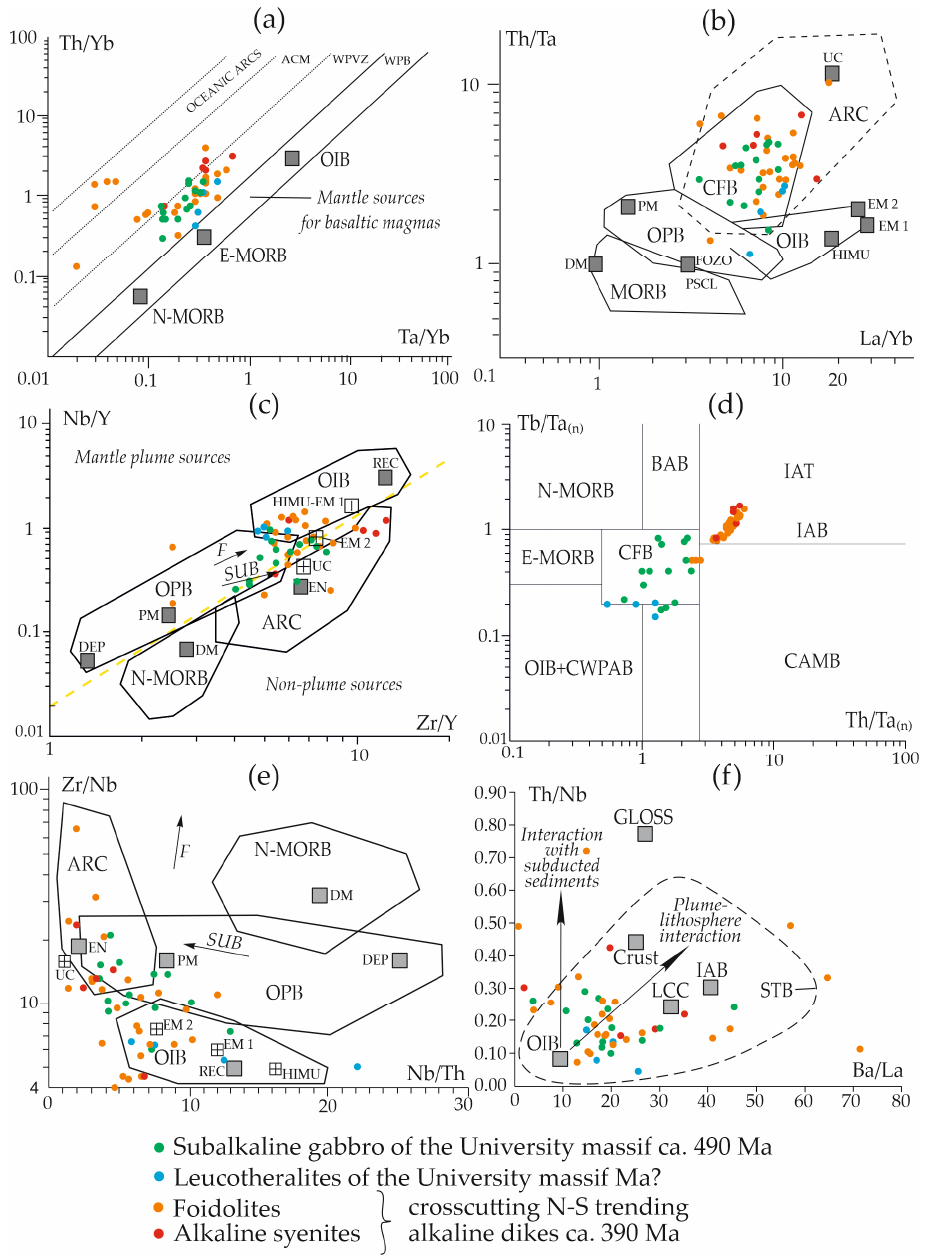
Figure 11. Variation diagrams of HFSE in subalkaline and alkaline rocks of the University pluton. ( a ) Th/Yb–Ta/Yb [80]: Oceanic arcs, ACM = active continental margins, WPVZ = within-plate volcanic zones, WPB = within-plate basalts, OIB = ocean island basalts, E-MORB = “enriched-type” mid-ocean ridge basalts, N-MORB = “normal-type” mid-ocean ridge basalts; ( b ) Th/Ta–La/Yb [81,82]: OPB = oceanic plateau basalt, SZB = subduction zone basalt, UC = upper crust, ARC = subduction zone basalts, CFB = continental flood basalt, PM = primitive mantle, HIMU = type basalt; HIMU = means high µ, where the µ-value is the ratio of 238 U/ 204 Pb. EM I-type basalt and EM II-type basalt = basalts from enriched mantle sources, DM = depleted mantle, FOZO = focal zone; ( c ) Nb/Y–Zr/Y and ( e ) Zr/Nb–Nb/Th [83]: Arrows indicate effects of batch melting (F) and subduction (SUB). DEP = deep depleted mantle, EN = enriched component, REC = recycled component; ( d ) Tb/Ta(n)–Th/Ta(n) [84]: BAB = back-arc basin basalts, IAT = island arc tholeiites, IAB = island arc basalts, CAMB = active continental margin basalts, CWPAB = continental within-plate alkali and transitional basalts, (n) = primitive mantle-normalized [69]; ( f ) Th / Nb–Ba / La [85]: OIB [69], IAB [70], LCC = lower continental crust [86], Crust [87], GLOSS [88], STB = Siberian